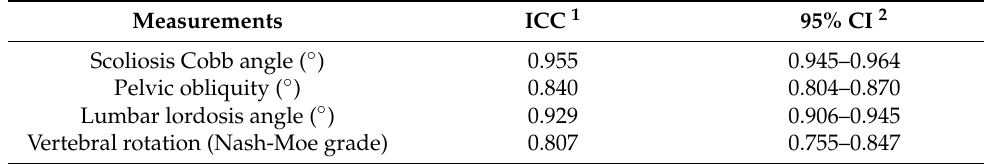
Table 2. Inter-rater reliability of radiographic measurements.